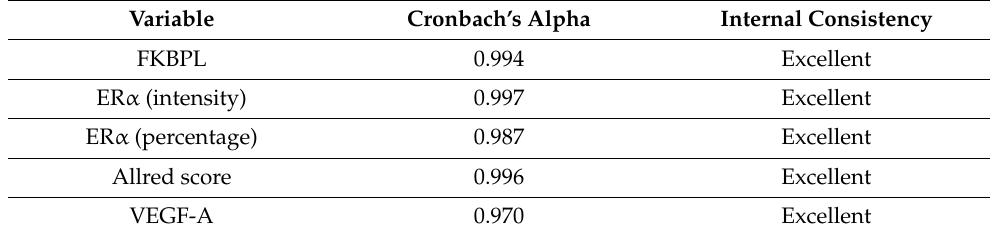
Table 2. Reliability of double-blind reading.